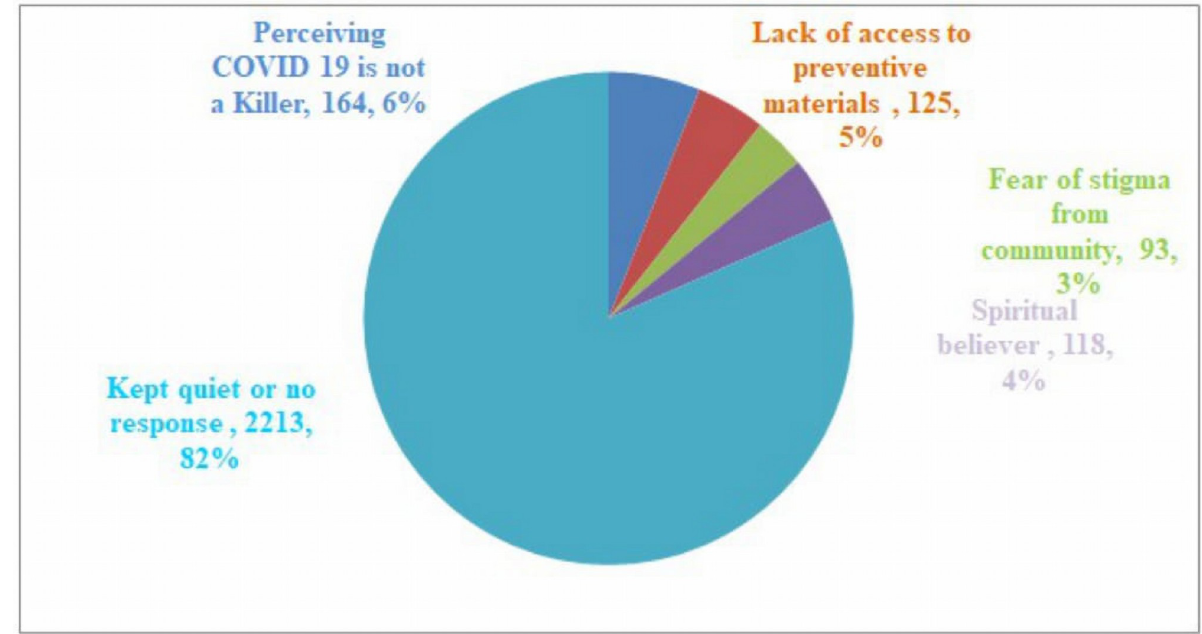
Fig 9. Reason for not adhering to COVID-19 preventive measures among study participants, Oromia region, Ethiopia, September 2020 to March 2021.